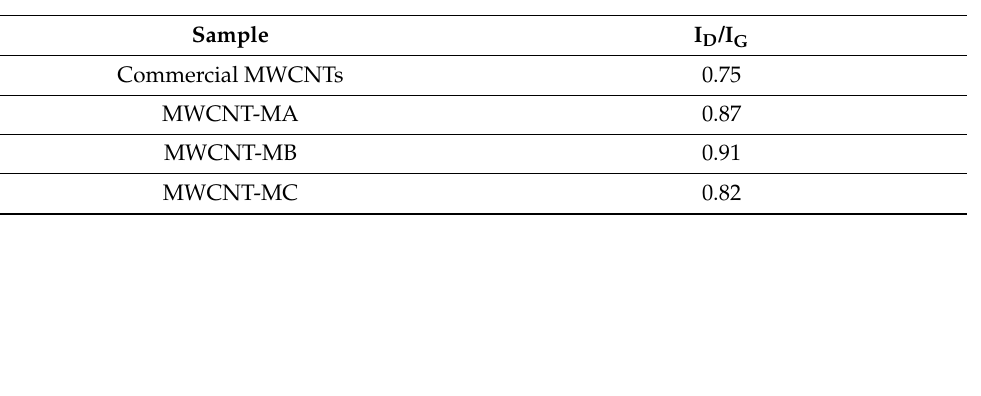
Figure 1. FTIR spectra of commercial and surface oxidized MWCNTs: ( a ) commercial MWCNTs ( b ); MWCNT-MA ( c ); MWCNT-MB and ( d ) MWCNT-MC. Table 4. The value of I D /I G ratio for commercial and surface oxidation of